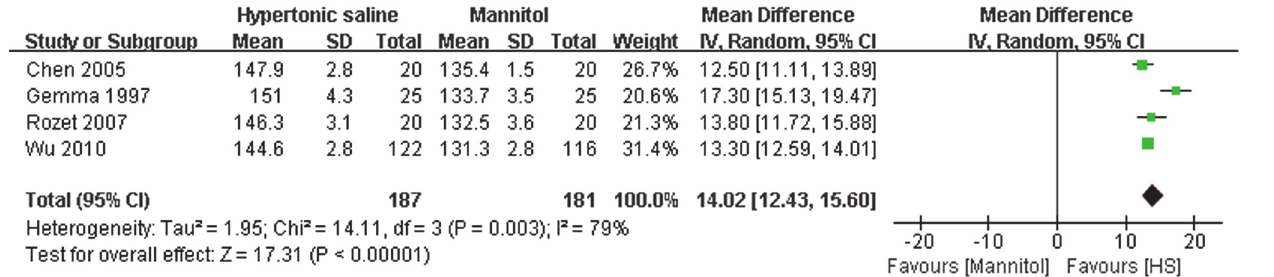
Fig 8. Maximal serum sodium in HS and mannitol groups. IV: Inverse Variance.